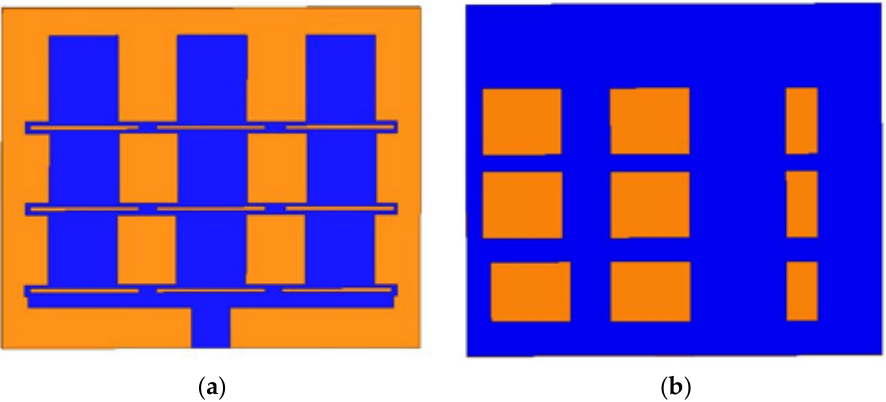
( b ) Figure 4. ( a ) Top view of the antenna (O) showing the patch array structure of the antenna, ( b ) bottom view of the antenna showing the ground plane with the second set of three cuts. To further improve the impedance matching at the dual band, the final modifications are made to the ground part of antenna O by etching one more row of square slots, thereby resulting in 9 cuts in the ground plane. The introduction of these slots further affect the surface current behavior of the antenna, thereby improving the impedance matching of the antenna. This antenna is now termed as P (proposed antenna). The representation of the antenna structure is shown in Figure 5a,b. The cuts that were introduced in the ground plane are in the form of a 3 × 3 array structure. The last row of cuts formed consists of two cuts of dimensions W G × L C and one cut of dimensions W C × L C . The last cut that lies close to the ground’s boundary is slightly misaligned to the cut made in the first stage and aligned to the cut made in the previous stage for obtaining a proper frequency response for the required dual-band operation. Thus, one of the cuts in the final proposed antenna is misaligned to the other cuts of the same column. The reflection coefficient of the an-